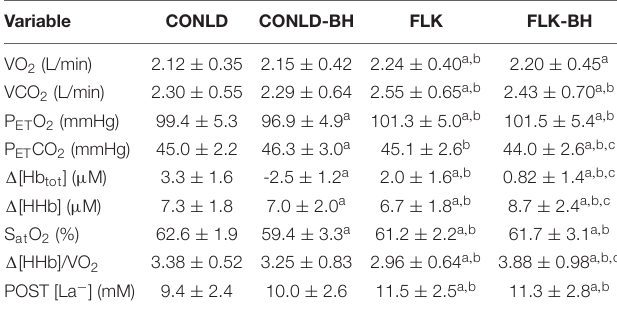
TABLE 3 | Mean outcome measures for each of the four conditions, namely, CONLD, CONLD-BH, FLK, and FLK-BH from 0 to 360